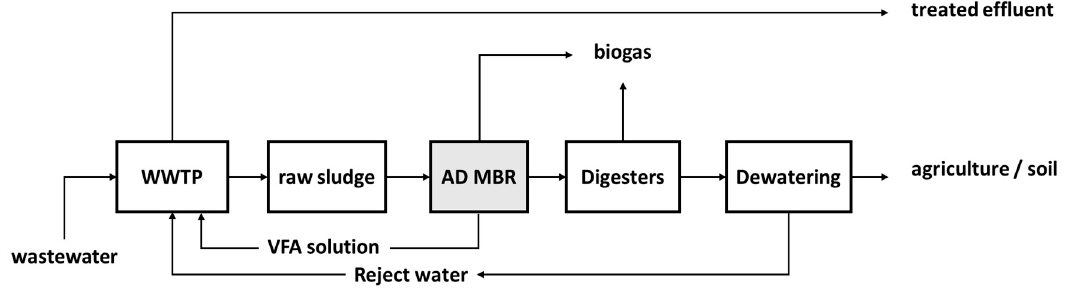
Figure 6. An overview of the proposed scenario two.